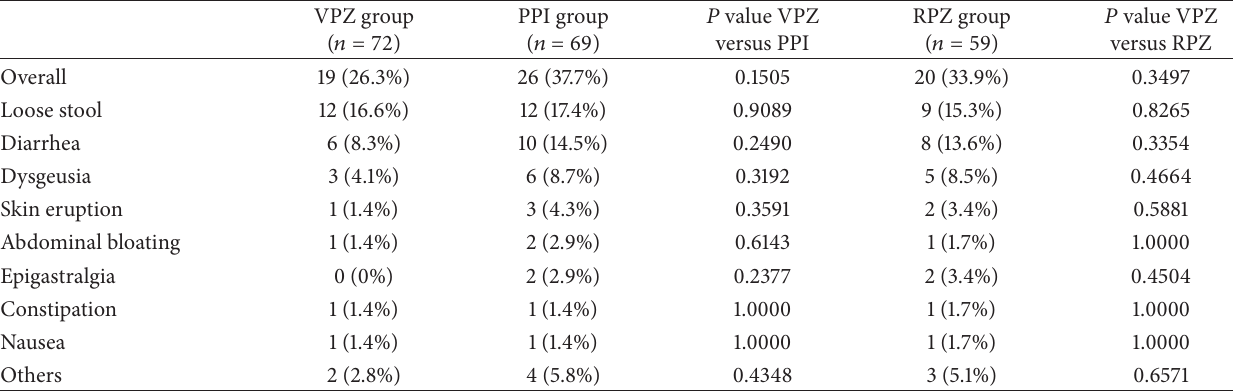
Table 2: Incidence of adverse